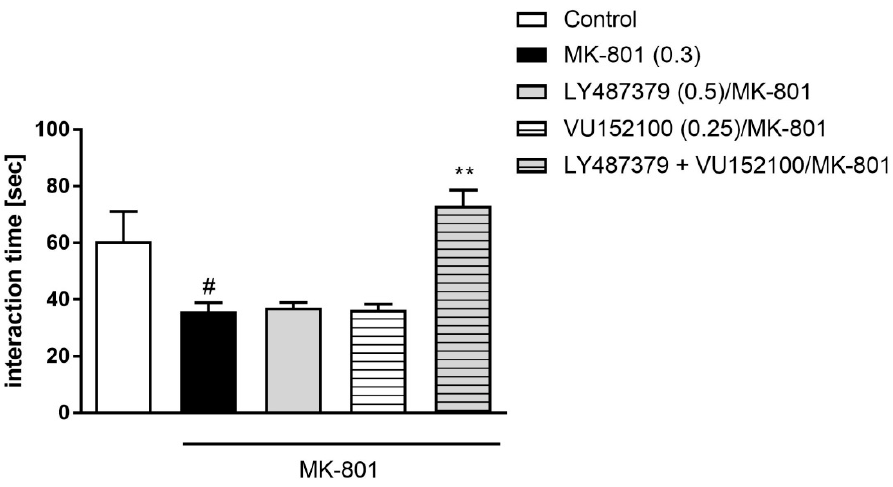
Figure 6. Social interaction test in mice after chronic administration (7 days) of investigated inacuteMK-801model. Investigateddosesareindicatedinparentheses. Barsrepresentthemeans ± SEM. compounds in acute MK-801 model. Investigated doses are indicated in parentheses. Bars represent N = 8–10 pairs / group. # p < 0.001 versus the control group and ** p < 0.01 versus LY487379 or the means ± SEM. N = 8–10 pairs/group. # p <0.001 versus the control group and ** p < 0.01 versus LY487379 or VU152100.